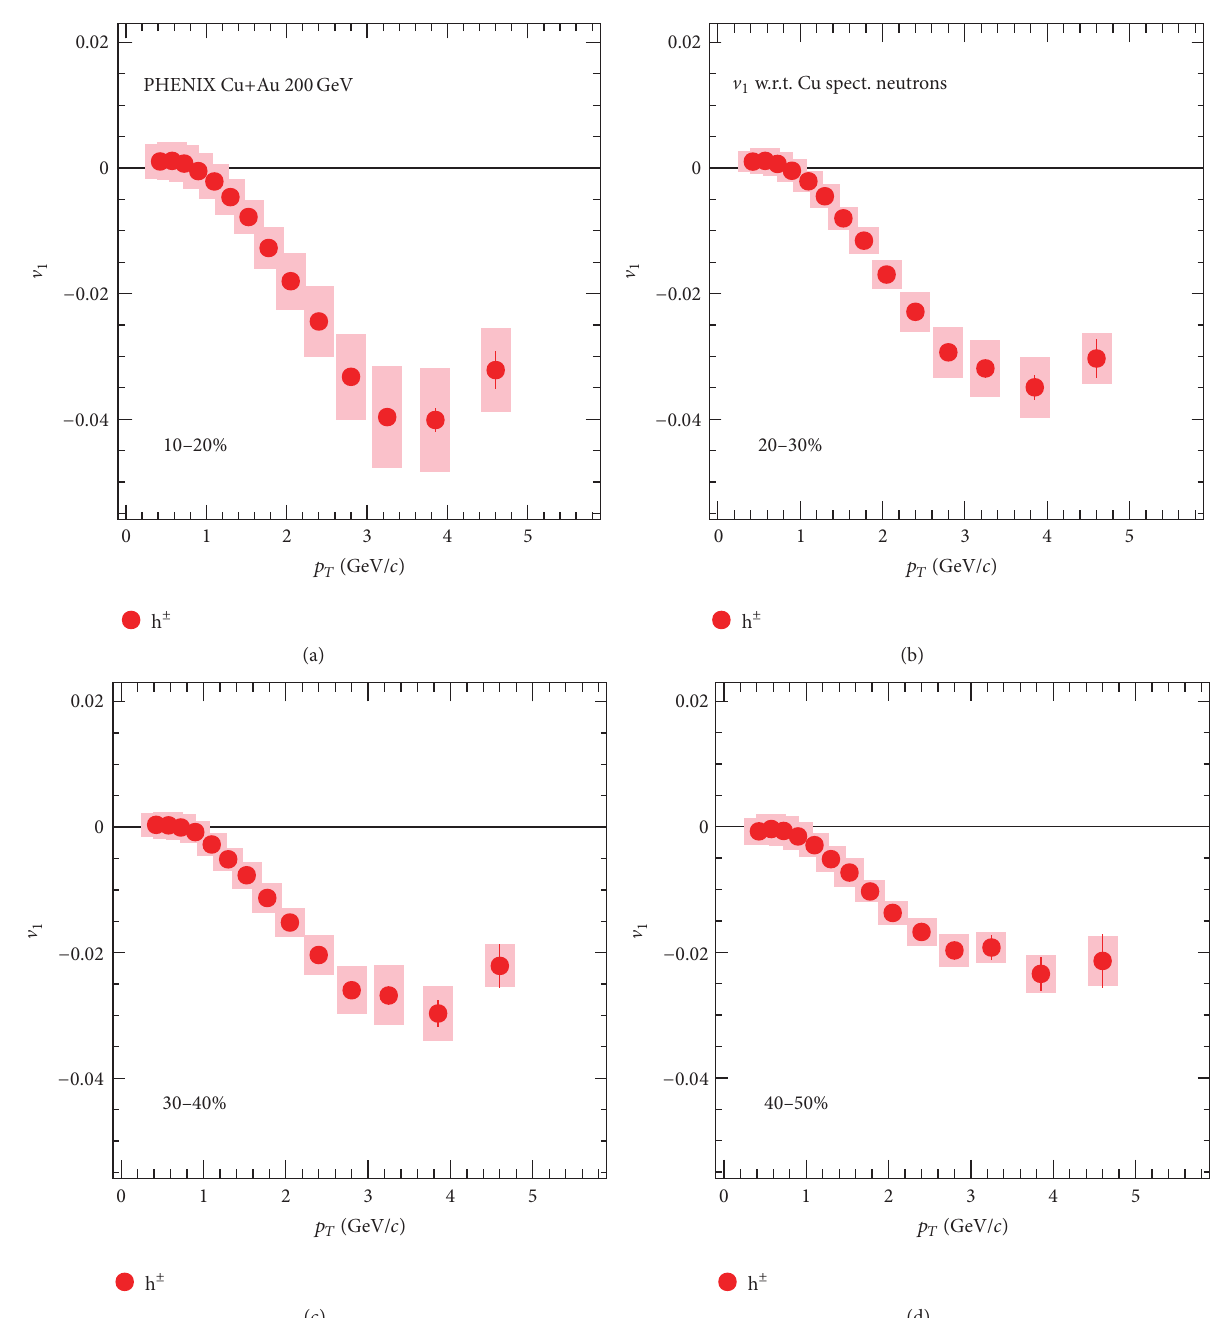
Figure 5: Midrapidity V 1 (𝑝 𝑇 ) in Cu+Au collisions at √𝑠 NN = 200 GeV in four bins of centrality, as reported by the PHENIX collaboration